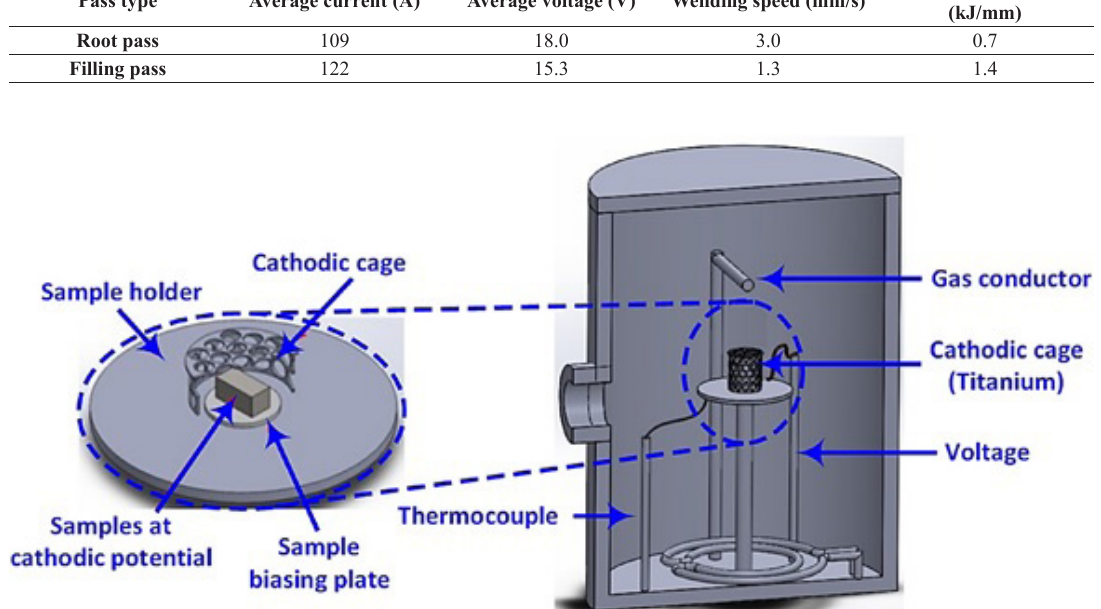
Table 2. Parameters of the welding process. Pass